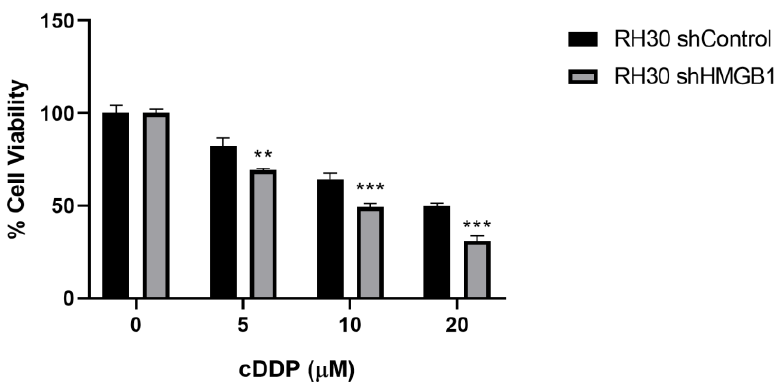
Figure 6. Sensitivity to cisplatin treatment in RH30 cell lines after HMGB1 knockdown. RH30 transduced with shHMGB1 lentivirus were treated with cisplatin (cDDP) at 5, 10 and 20 µM over 48 h and percentage of cell viability was compared versus RH30 transduced with shControl lentivirus. ** p < 0.01, *** p < 0.001, Student t test. The data from one of two independent experiments are shown.